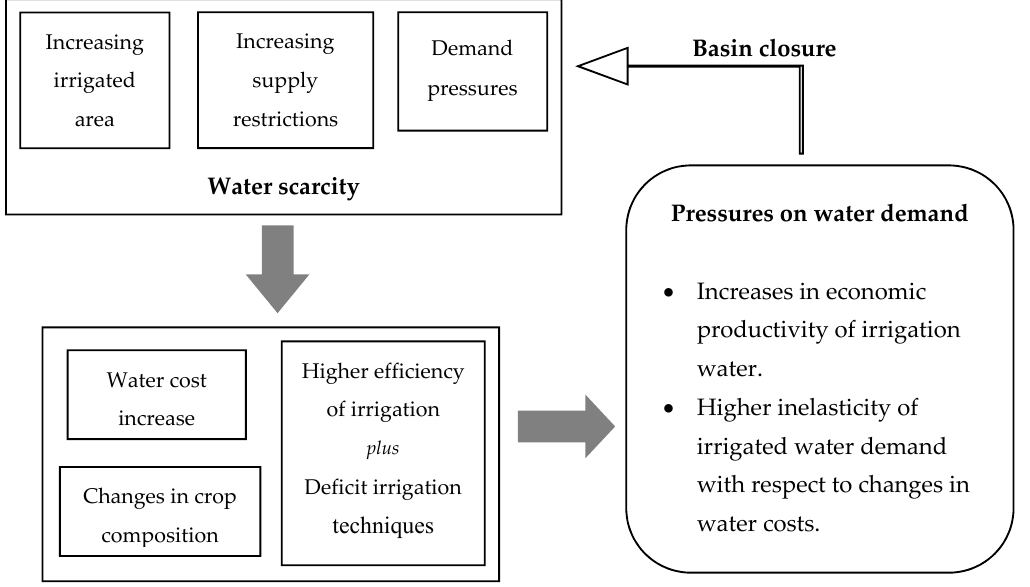
Figure 2. Model of a basin closure process. (Adapted from Berbel et al. [18]).